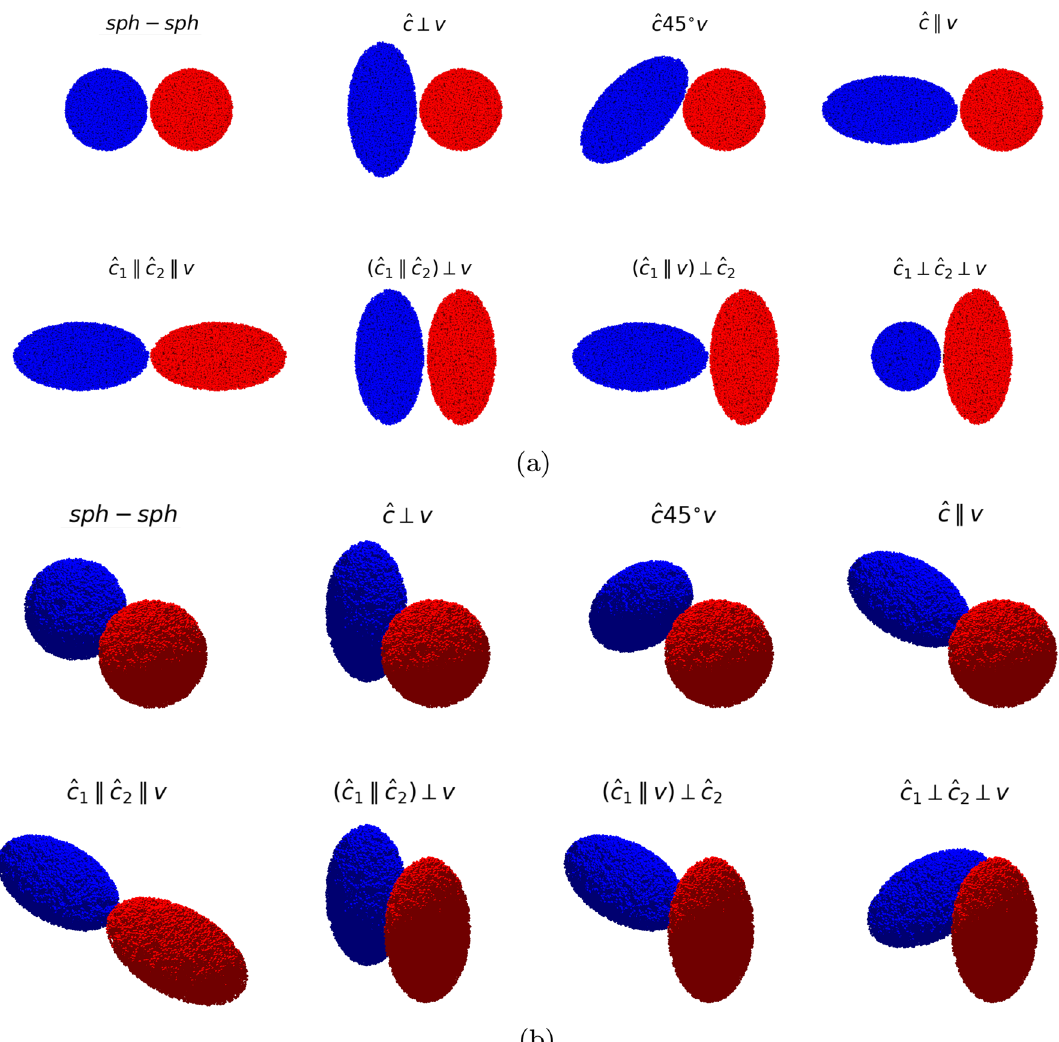
Figure 1. Set-ups of all collision events studied in this work. ( a ) Plane view; the collision velocity is in the horizontal direction. ( b ) 3D view, in which the viewing direction makes an angle of 45 ◦ with all axes. A light source is placed on the top of each setup to illuminate the aggregates for emphasizing their 3D shape and orientation. Figure created using POV-Ray 23